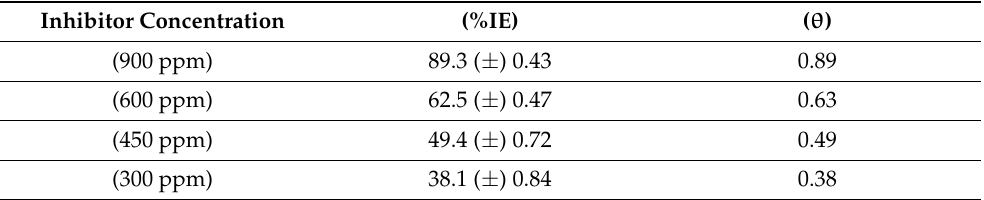
Table 6. IE and fractional surface coverage values (θ) were gained using a weight loss technique for aluminum in an aqueous solution of 1 M HCl for two hours in the absence and presence of different concentrations of honey as the inhibitor. The standard deviation is shown by the (±) sign, and these numbers represent the average of three measurements.